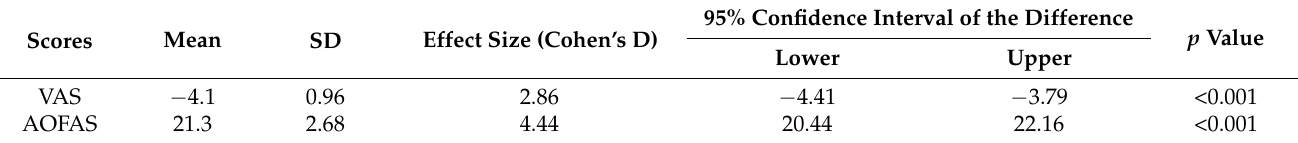
Table 1. The paired t -test of VAS and AOFAS scores.